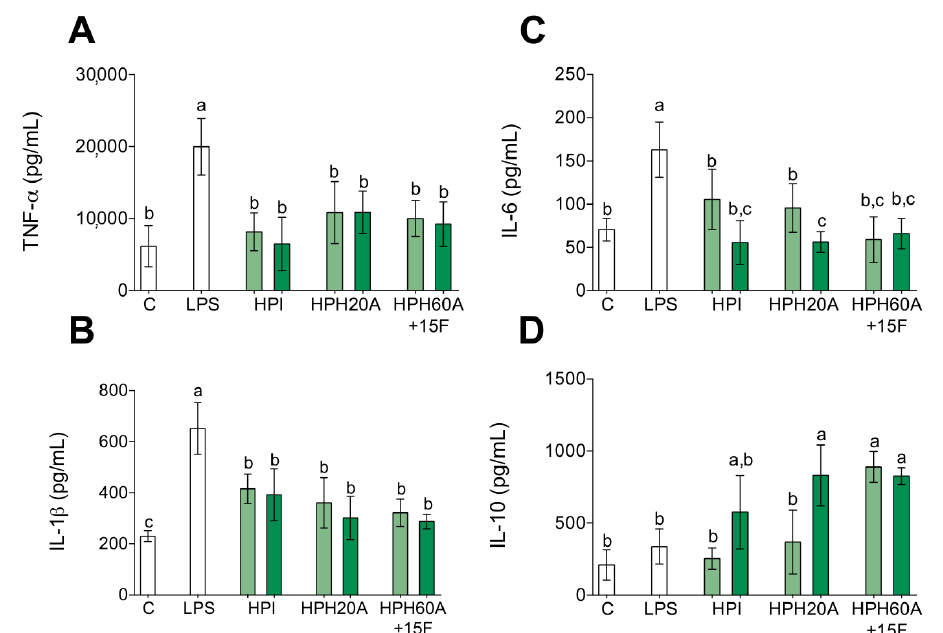
Figure 2. E ff ect of HPPs on inflammatory cytokine release in LPS-stimulated primary human monocytes. Monocytes were activated with LPS (100 ng / mL) and then treated with HPI, HPH20A, and HPH60A15F at 50 (light green bar) and 100 (dark green bar) µ g / mL for 24 h. Concentration of TNF- α ( A ), IL-1 β ( B ), IL-6 ( C ), and IL-10 ( D ) in culture supernatants was detected by ELISA. Data are presented as means ± SD ( n = 3) and the significantly different ( p < 0.05) are labeled with contrasting letters.